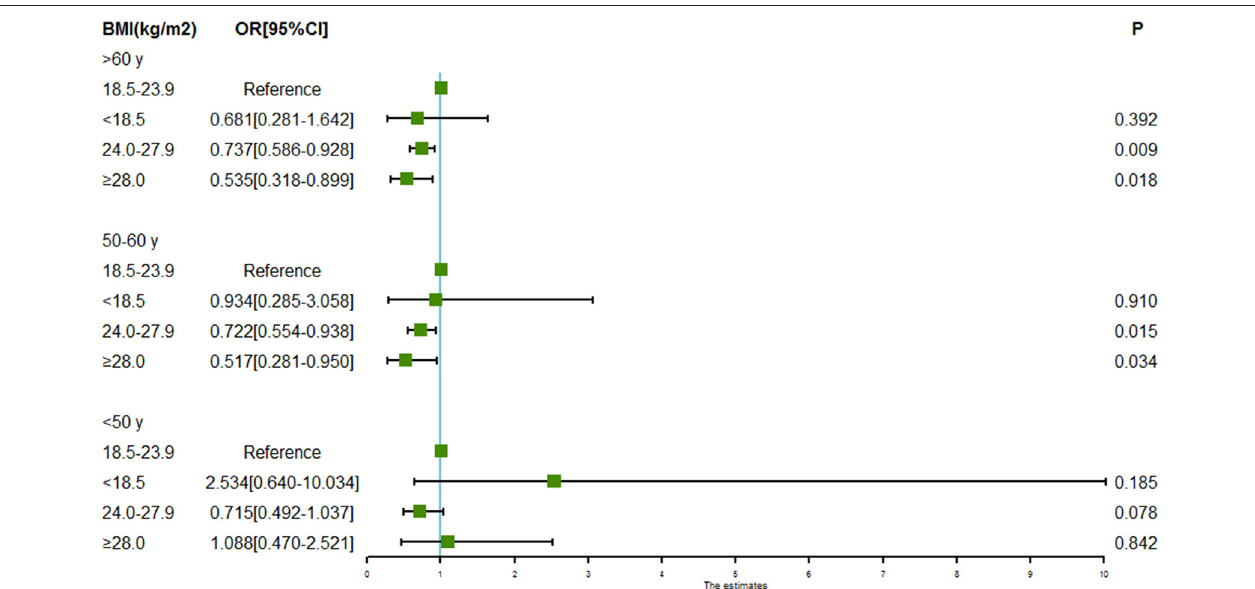
FIGURE 3 | Forest plot of ORs for the association between BMI and intracranial aneurysm rupture stratified by age. Both the BMI 24.0 to < 28.0 kg/m 2 and the BMI ≥ 28.0 kg/m 2 were associated with a lower risk of intracranial aneurysm rupture in patients aged 50–60 years and patients aged > 60 years. However, no association was found between BMI and intracranial aneurysm rupture in patients aged < 50